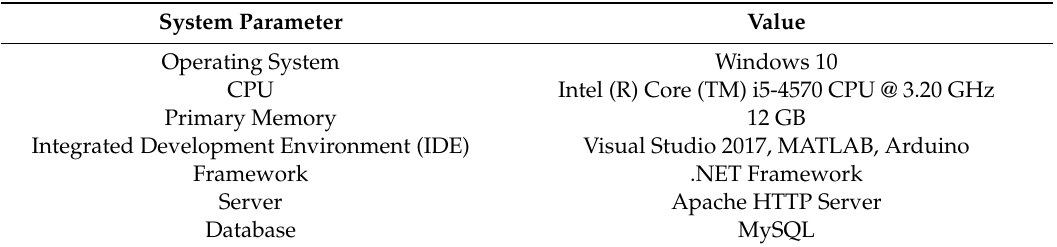
Table 5. Specification of implementation environment of general-purpose PC.